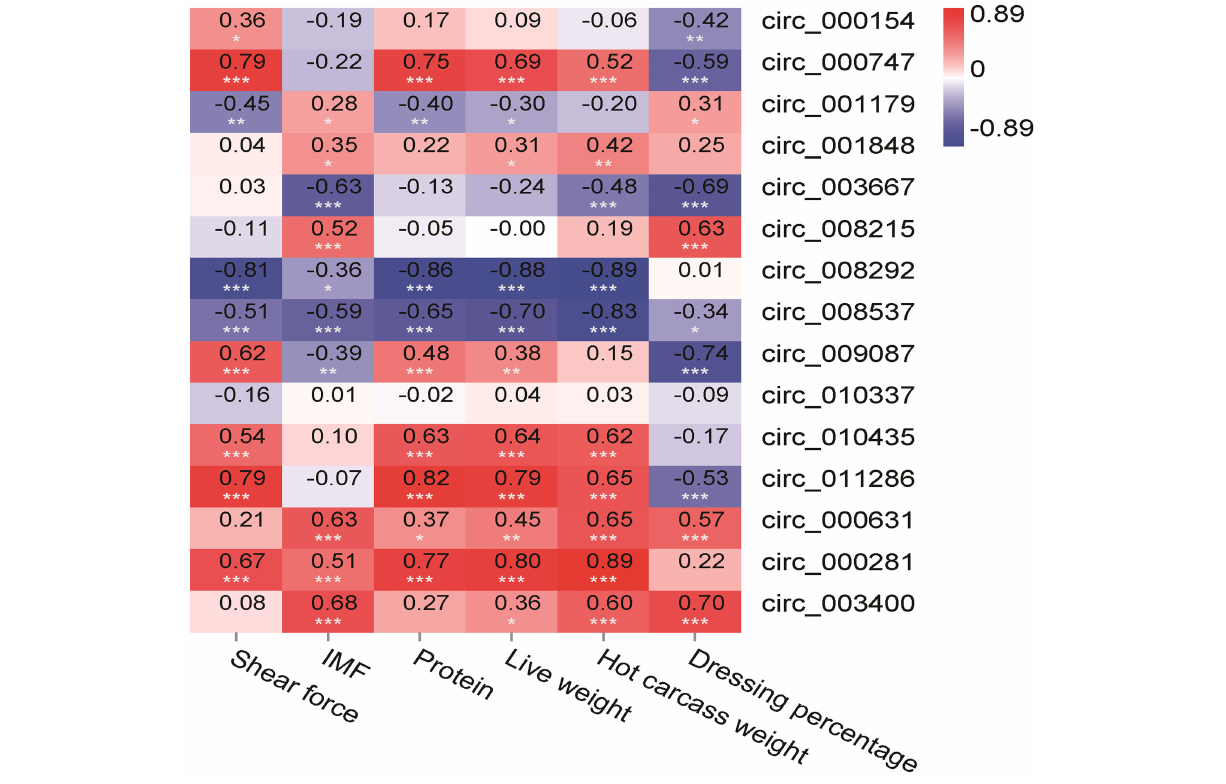
FIGURE 7 | Pearson correlations between expression of circRNAs and slaughter performance and meat quality in the LT muscle of Tibetan sheep. *Correlation is significant at p < 0.05, **correlation is significant at p < 0.01, ***correlation is significant at p <